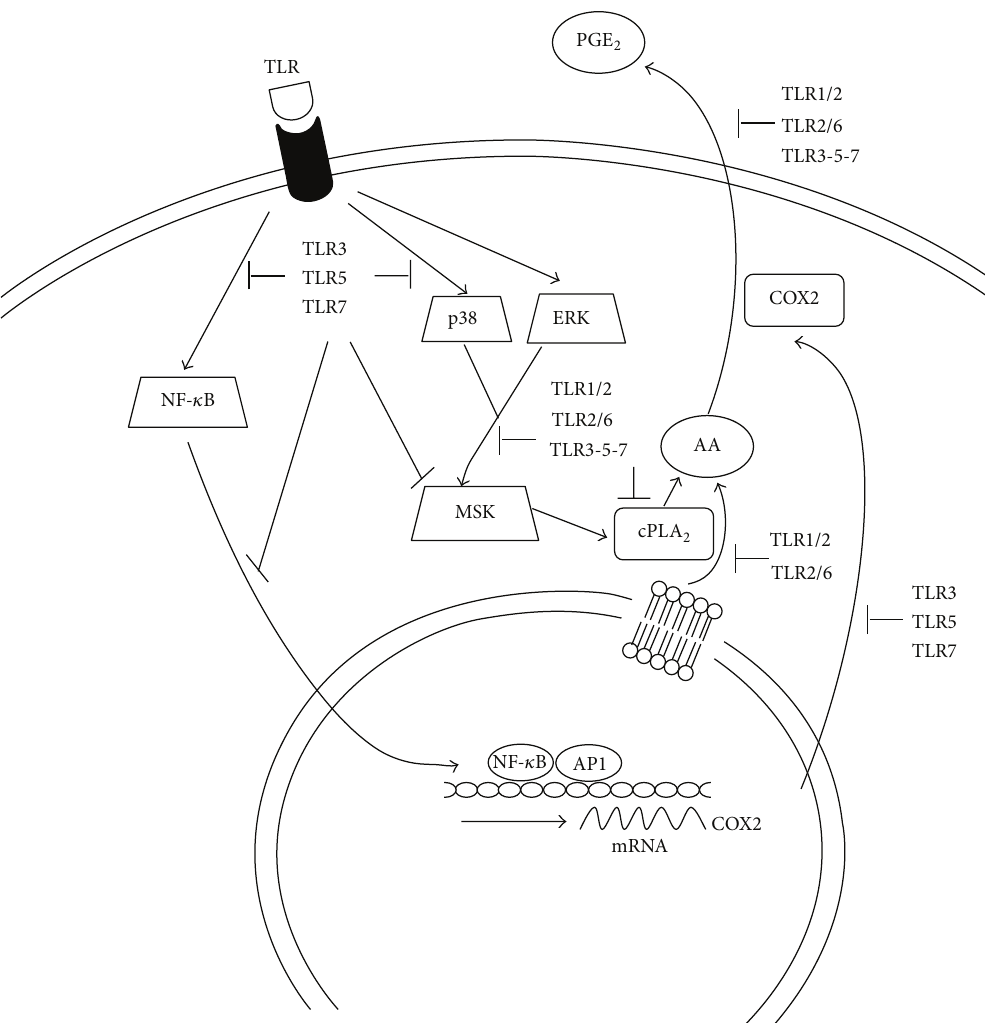
Figure 6: Mechanisms of PGE 2 production by TLR family members. TLR4 triggering induces the transcription of COX2 via NF- 𝜅 B and MAPK p38 and ERK1/2 as well as cPLA 2 phosphorylation and AA mobilization, presumably via MAPK and/or MSK1, which is in turn converted into PGE 2 by COX2 and released into the medium. Similar mechanisms of action can be envisaged when TLR7 and 8 are concomitantly activated by R848. TLR3, TLR5, and TLR7 fail to activate NF- 𝜅 B and selected MAPKs, thus hindering the transcription of COX2. By contrast, TLR1/2 and TLR2/6 cause no PGE 2 release because of inefficient cPLA 2 phosphorylation and AA mobilization, which may correlate with their inability to phosphorylate